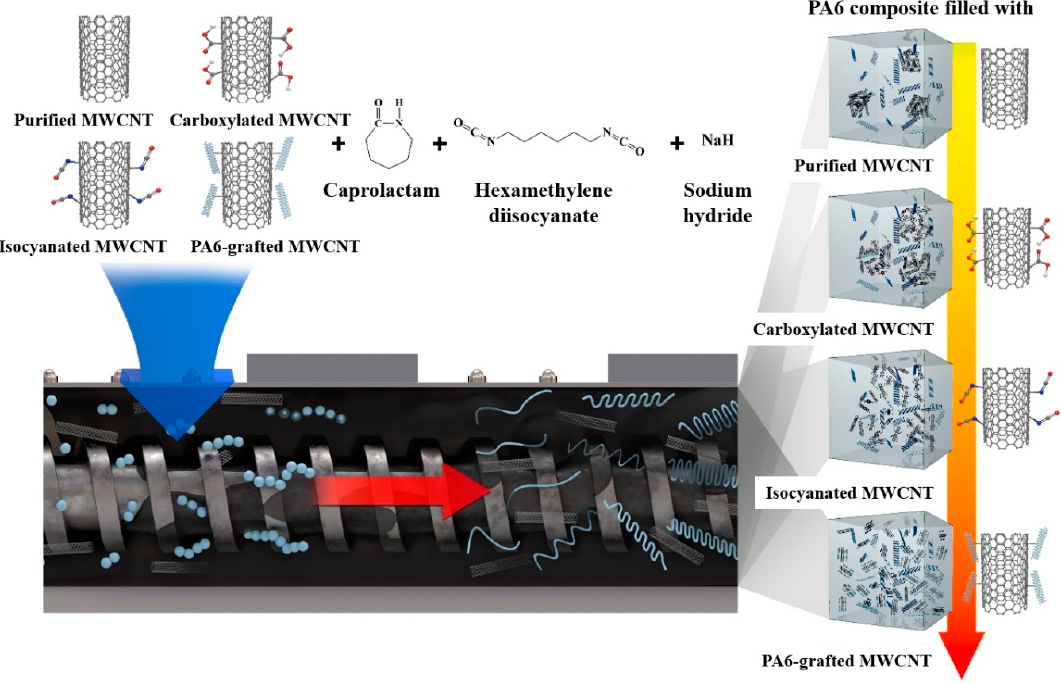
Figure 1. Schematic of the applied strategy.